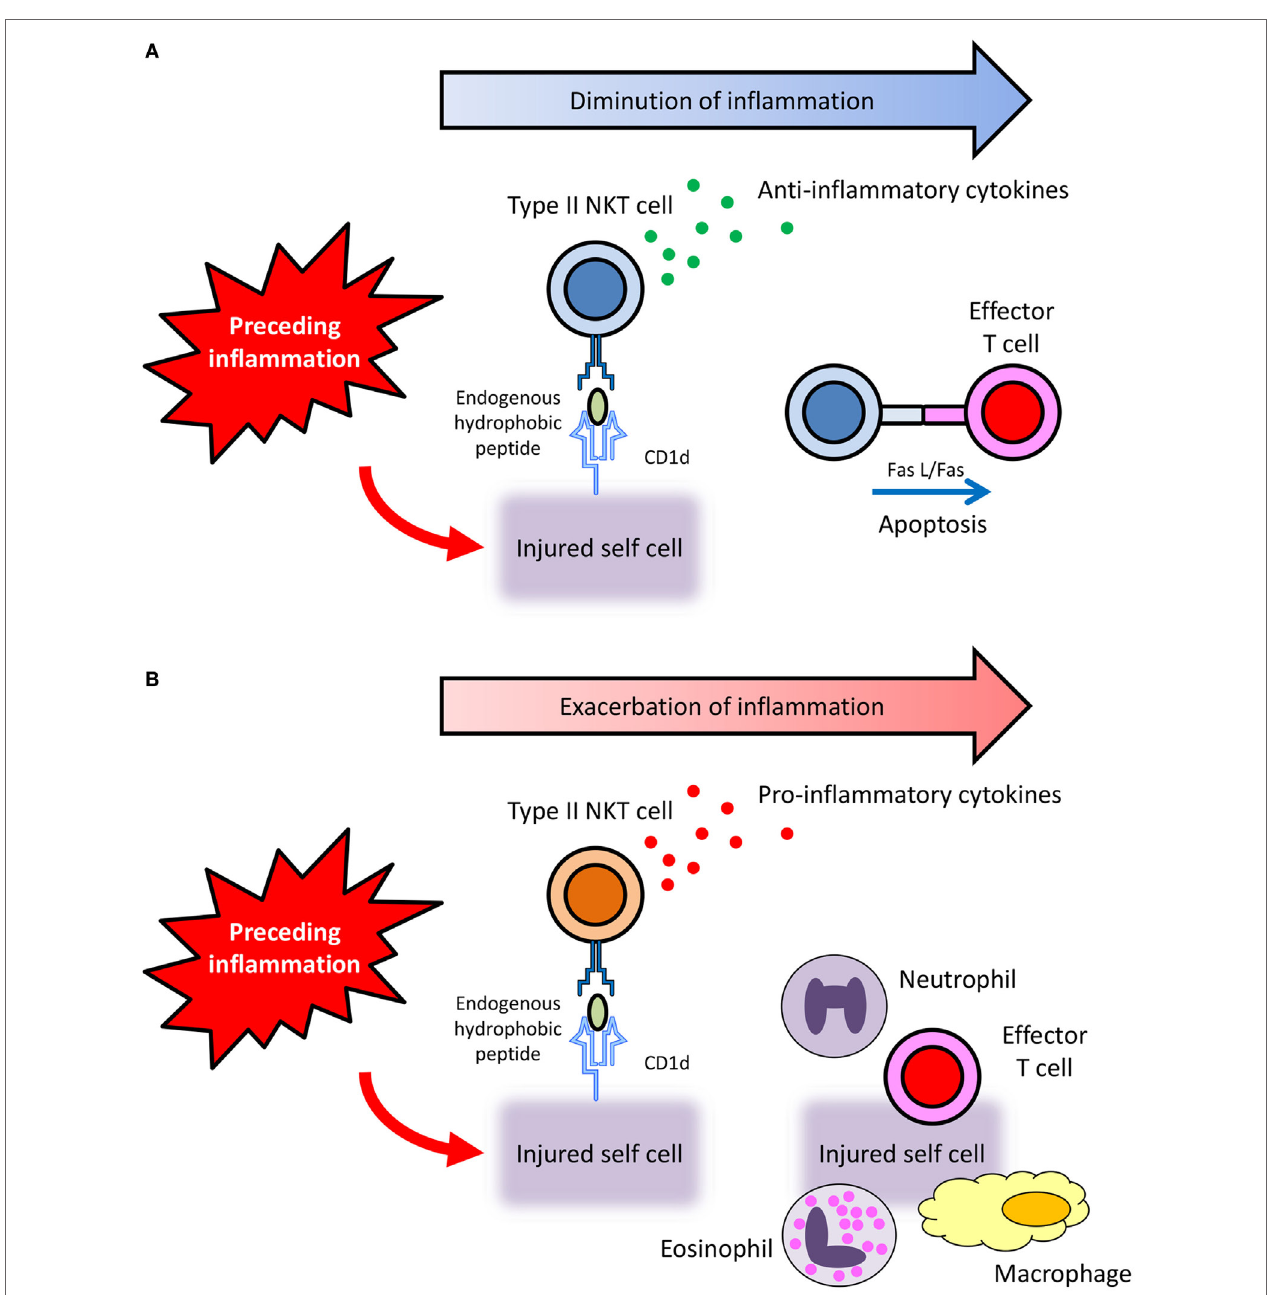
FiGURe 1 | Hypothetical diverse roles of CD1d-restricted type II NKT cells that recognize endogenous hydrophobic peptides. (A) Preceding inflammation sometimes results in the injury of own tissues. Under such situation, injured cells then present hydrophobic autoantigens, probably peptides, on their CD1d to activate CD1d-restricted type II NKT cells. Thereafter, activated CD1d-restricted type II NKT cells function to diminish inflammation by producing anti-inflammatory cytokines and by inducing apoptosis of effector cells via Fas/FasL interaction. (B) When CD1d-restricted type II NKT cells activated by endogenous hydrophobic peptides produce pro-inflammatory cytokines, the inflammation is